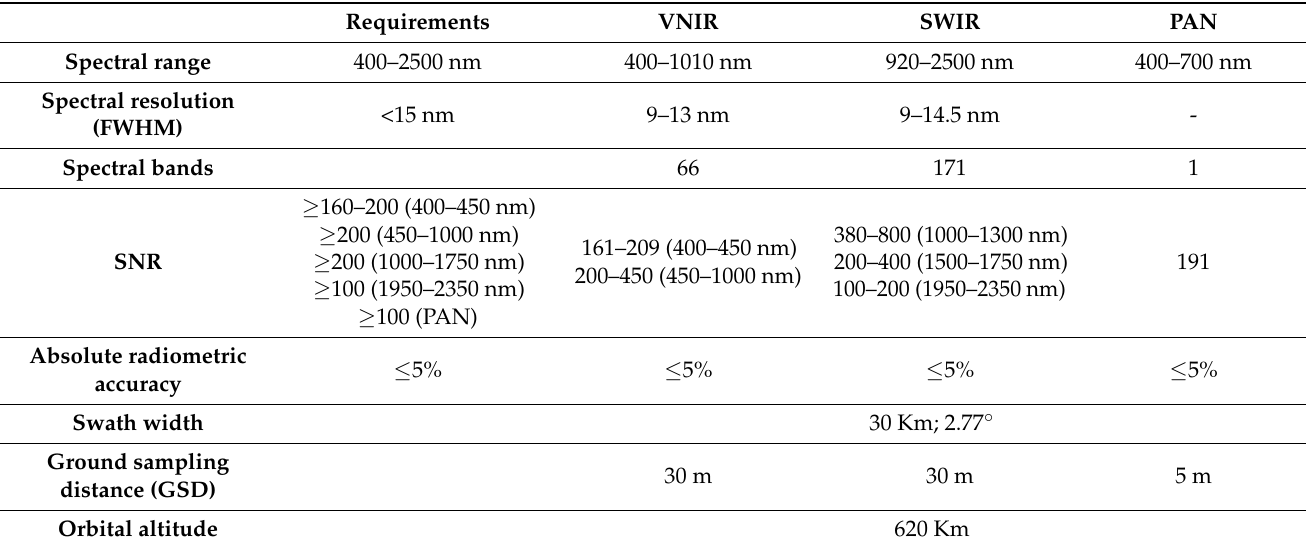
Table 1. PRISMA payloads’ main characteristics. The first column reports the requirements, while the last three specify the sensor performance as derived by the Leonardo Company and reported by